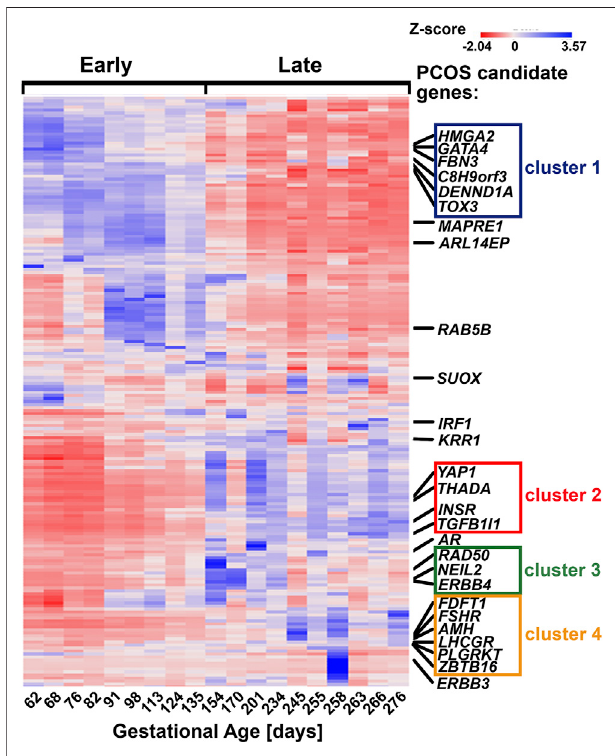
FIGURE 2 | Location of PCOS candidate genes and their respective clusters on the supervised heatmap of 24,889 genes identi fi ed in the fetal ovaries(62 – 276 days, n (cid:1) 19)usingRNAsequencing.Eachclusterismadeup of PCOS candidate genes as well as genes co-expressed with them; detailed lists of each cluster can be found in Supplementary Tables S2 – S5